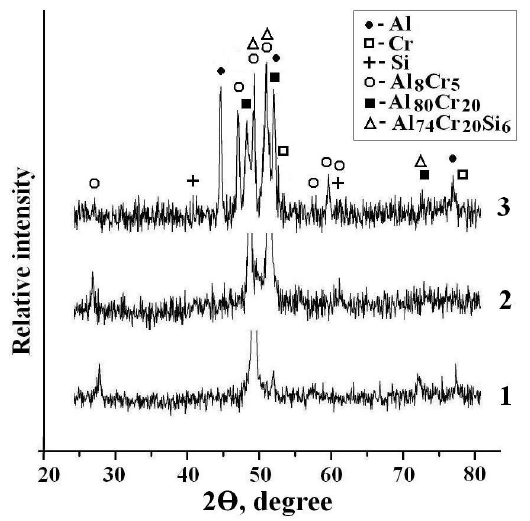
Figure 5. XRD patterns from the top of the modified layer of the cathodes: ( 1 ) Al 0.7 Cr 0.3 ; ( 2 ) Al 0.65 Cr 0.25 Si 0.1 ; ( 3 ) Al 0.6 Cr 0.2 Si 0.2